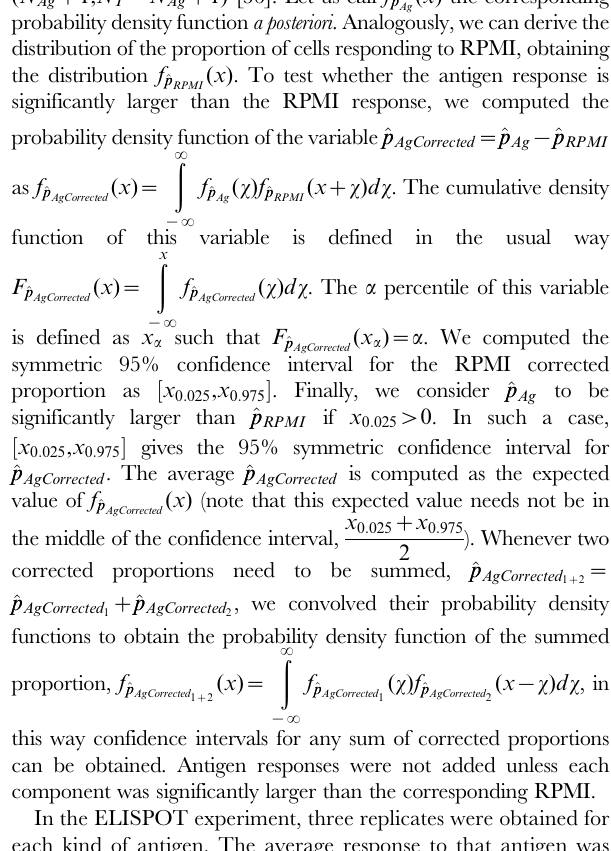
Table S1 Comparative HIV-1-specific immune responses